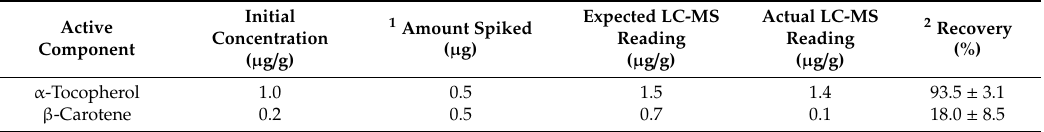
Table 1. LC-MS recovery of α -tocopherol and β